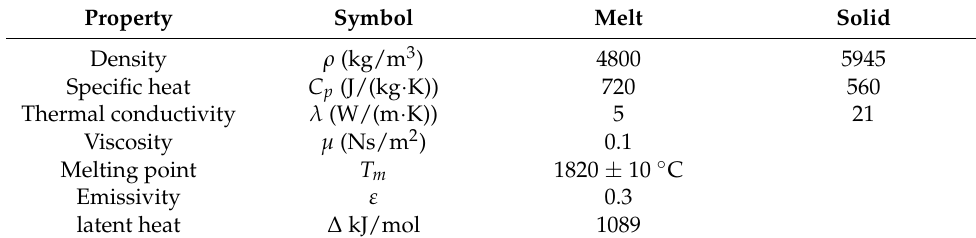
Table 1. Thermophysical properties of the Ga 2 O 3 melt